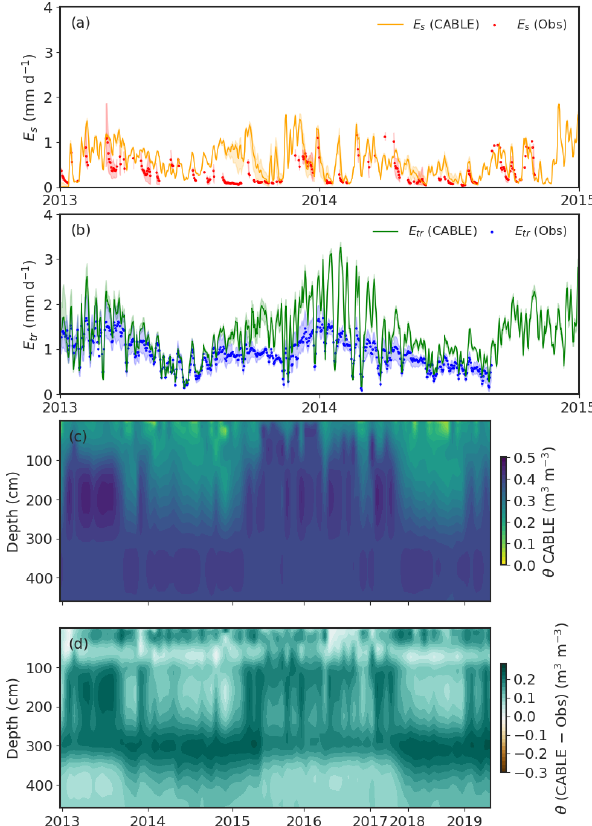
Figure 3. Increasing-soil-evaporation-resistance experiment (Sres). (a) E s between 2013 and 2015. (b) E tr between 2013 and 2015. In panel (a) and (b) the shaded areas represent uncertainty be- tween three ambient rings, and both simulations and observations are smoothed with a 3d window to aid visualisation. (c) The verti- cal distribution of θ in Sres at observed dates from 2013 to 2019. (d) θ difference between CABLE and observations. Note the different time axis for panels (c, d) relative to panels (a, b) due to different sampling intervals for soil moisture and